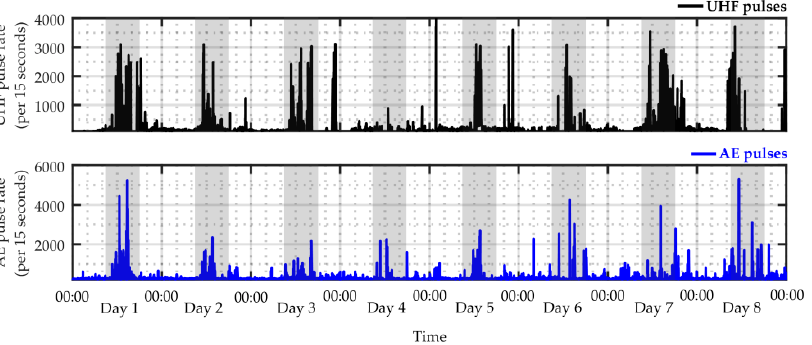
Figure 1. The result of the eight-day monitoring of the 31.5 MVA power transformer with the simultaneous use of the acoustic emission (AE) and ultrahigh frequency (UHF) method.